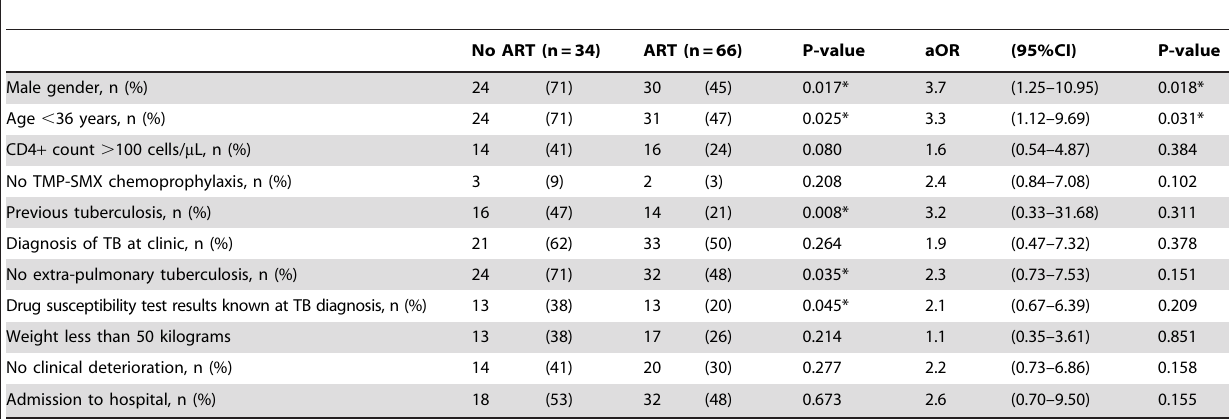
Table 2. Univariate analysis and logistic regression model showing factors associated with not initiating ART during TB